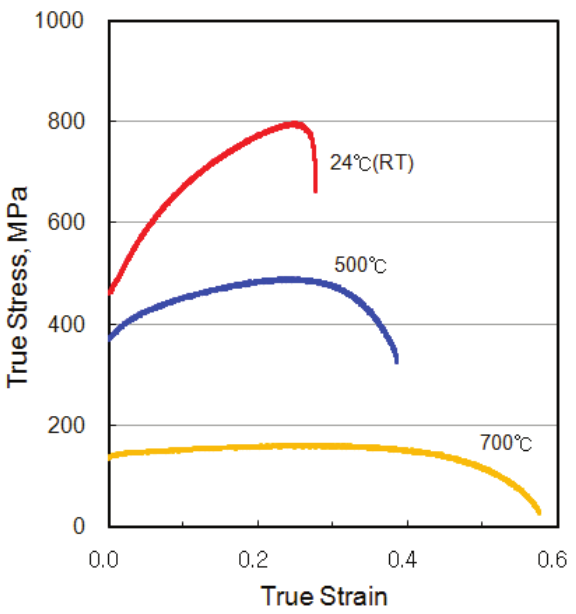
Figure 2. Stress-strain curves based on measured values.